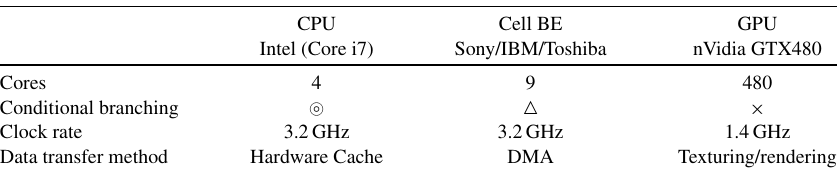
Processor comparison CPU vs. Cell BE vs. GPU*